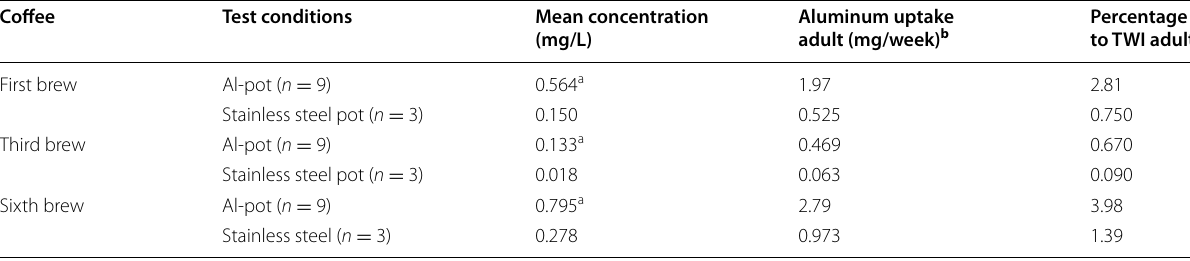
a The values shown are the arithmetic means of the results of three repetitions for each of three brands of moka pot b The weekly uptake is based on an adult weighing 70 kg and a daily uptake of 500 mL coffee over a time period of 1 week (7